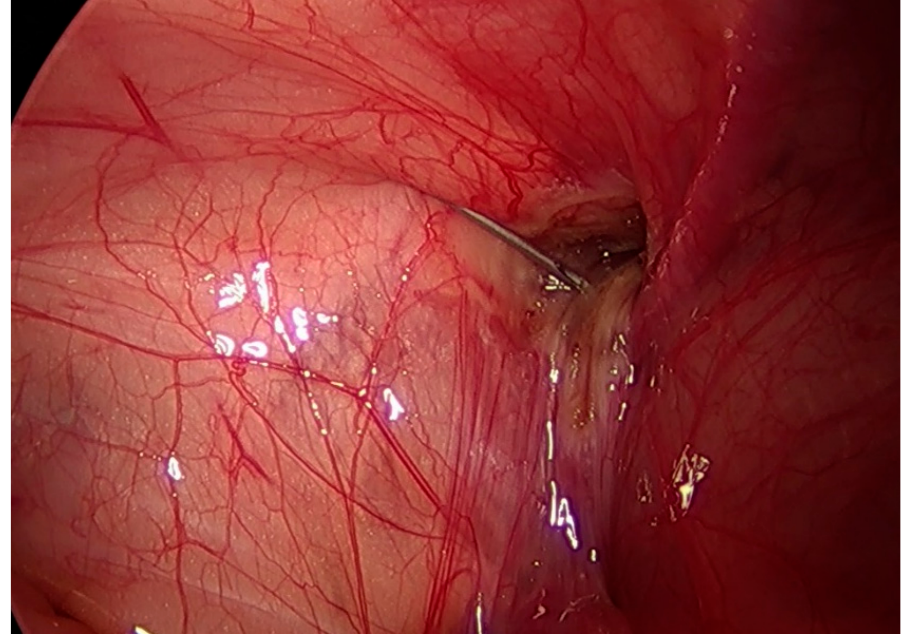
Figure 3. Histoacryl ® was injected and a long 25-gauge needle was used to close the internal inguinal ring.